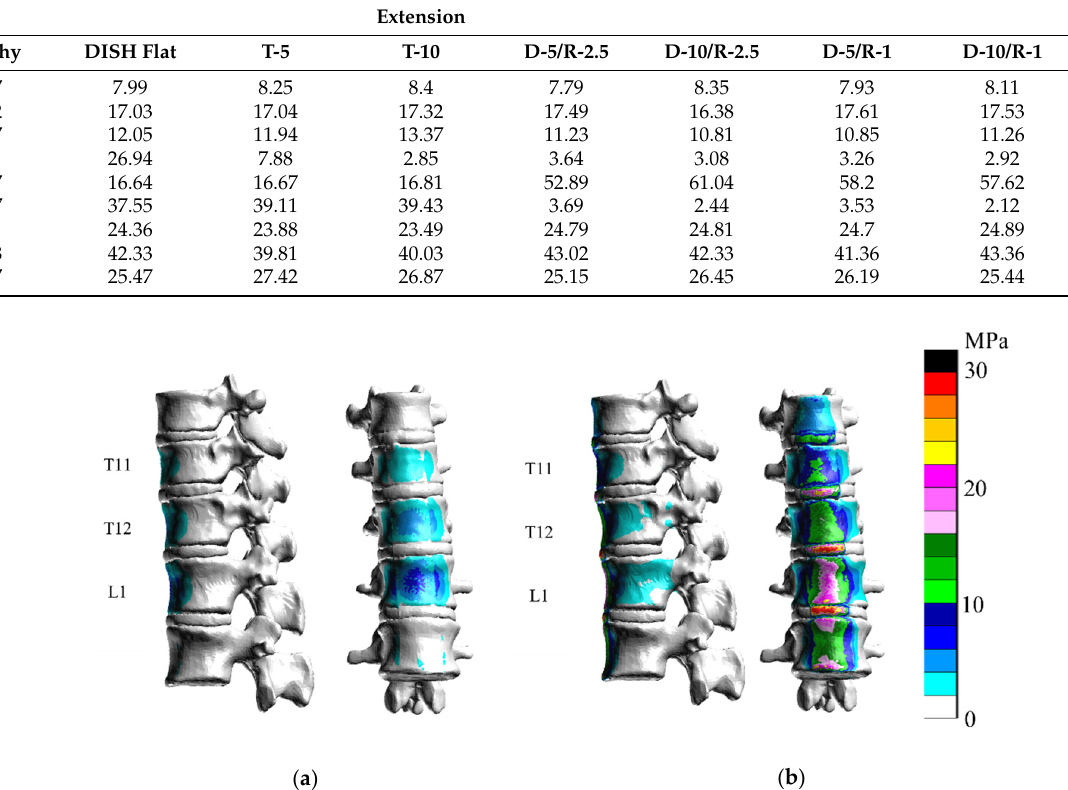
Table 3. The highest value for maximum von Mises stress on the vertebral body and intervertebral disc (MPa).